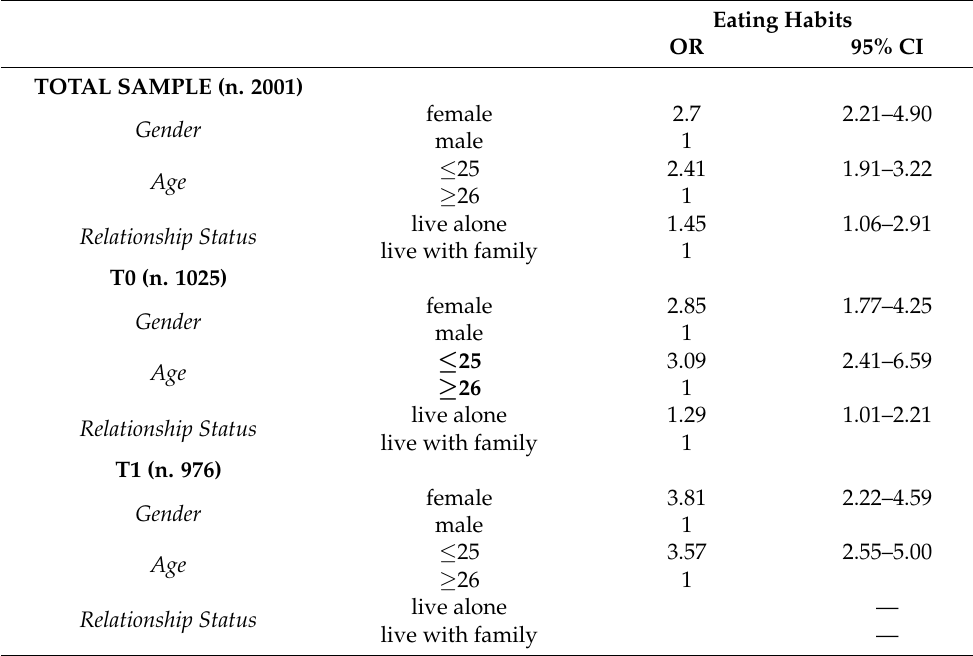
Eating Habits OR 95% CI